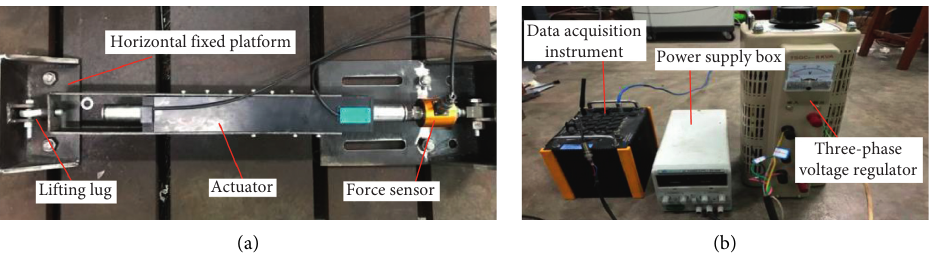
Figure 6: Force characteristic test of the actuator.